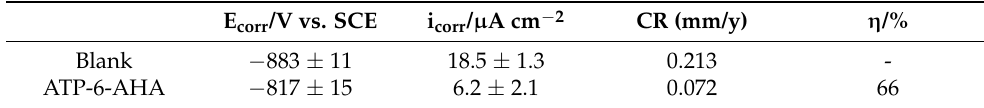
Table 2. Calculated data obtained from the potentiodynamic polarization curves of low carbon steel in 3.5% NaCl solution without and with the addition of ATP-6-AHA.